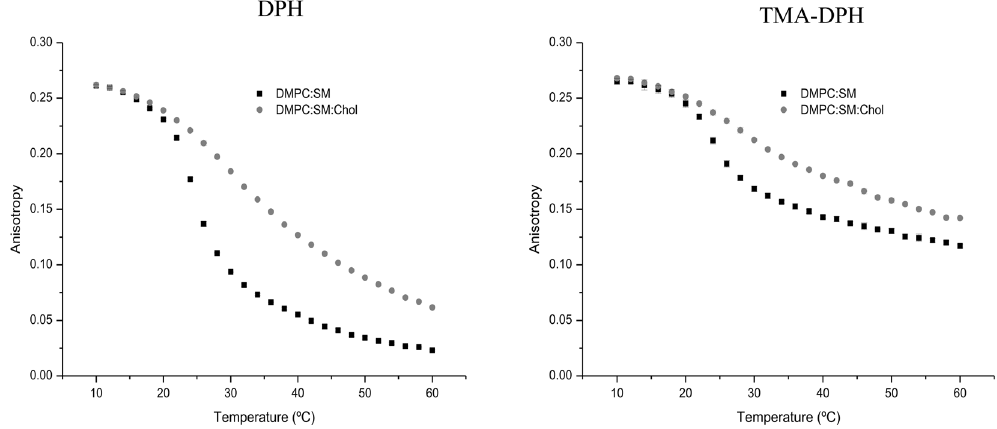
Figure 4. Steady-state anisotropy of DPH and TMA-DPH as a function of temperature in DMPC:SM [8:2] and DMPC:SM:Chol [7:1.5:1.5] membrane models. Results present the mean of at least three independent assays.